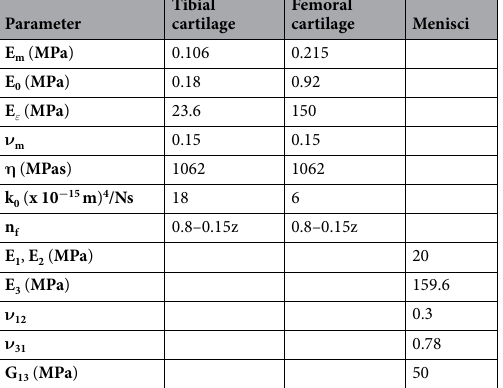
Table 2. Material parameters for cartilage 19 and menisci 65, 67–69 . E m = nonfibrillar modulus, E 0 = initial fibril network modulus, E ε = strain-dependent fibril network modulus, ν m = Poisson’s ratio, η = viscoelastic damping coefficient,